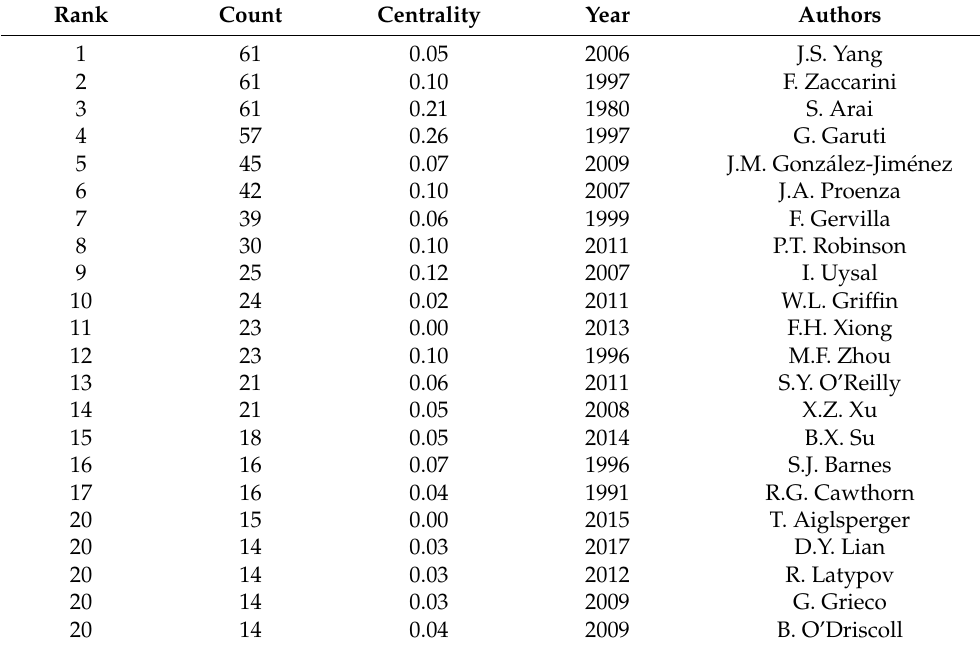
Table 1. Top 20 authors ranked by the number of publications with a focus on chromitite. Rank Count